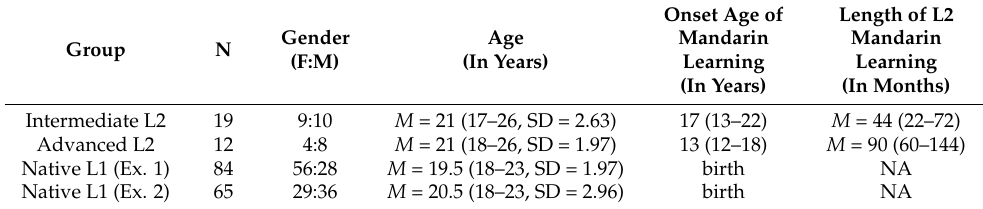
Table 1. Background information of the